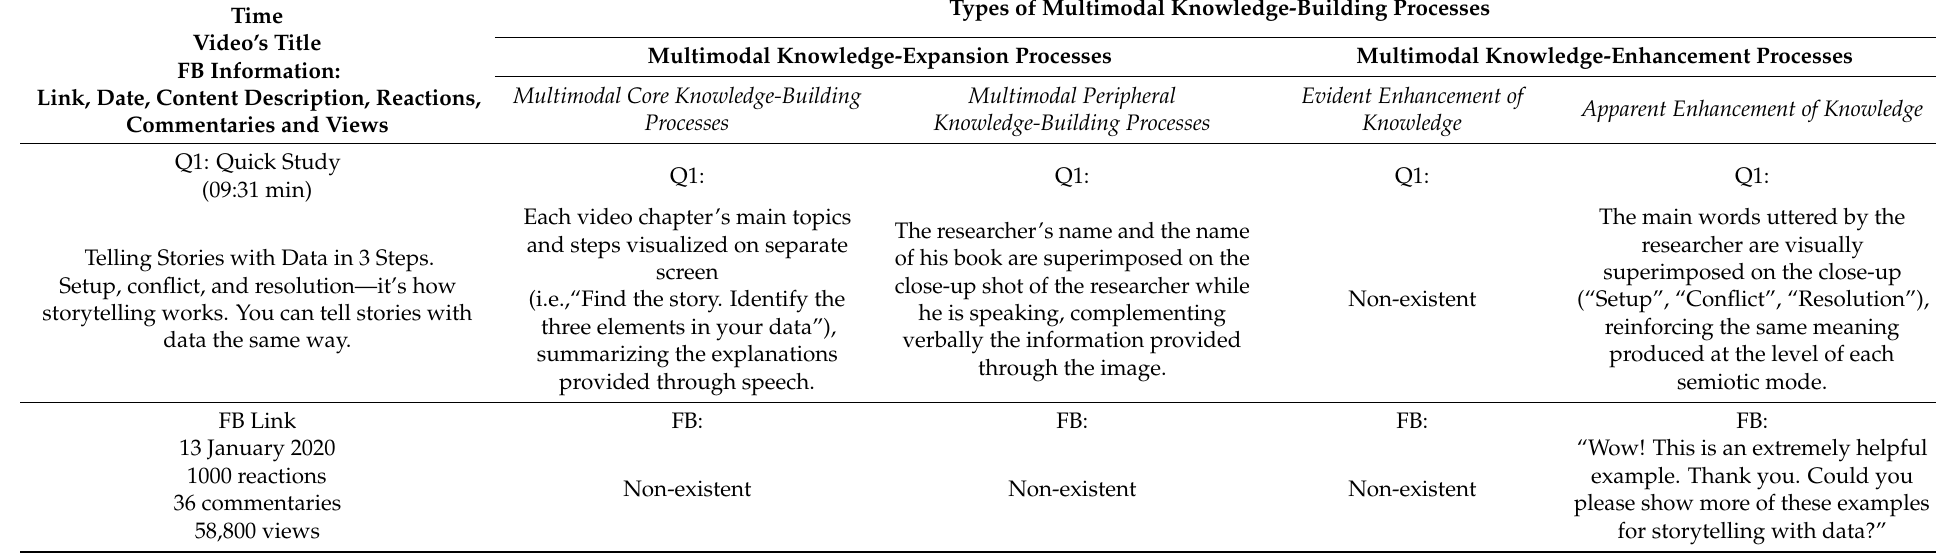
Table 3. Excerpt from the analysis table of Q1 related to multimodal knowledge-building processes existing in the video and in the FB